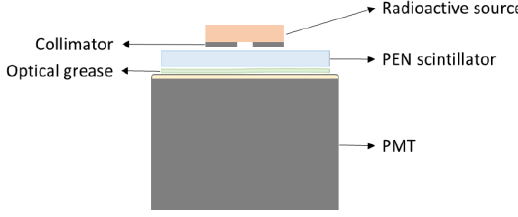
Figure 3. Schematic representation of the experimental setup for the PEN thin-film scintillators light yield measurement. yield